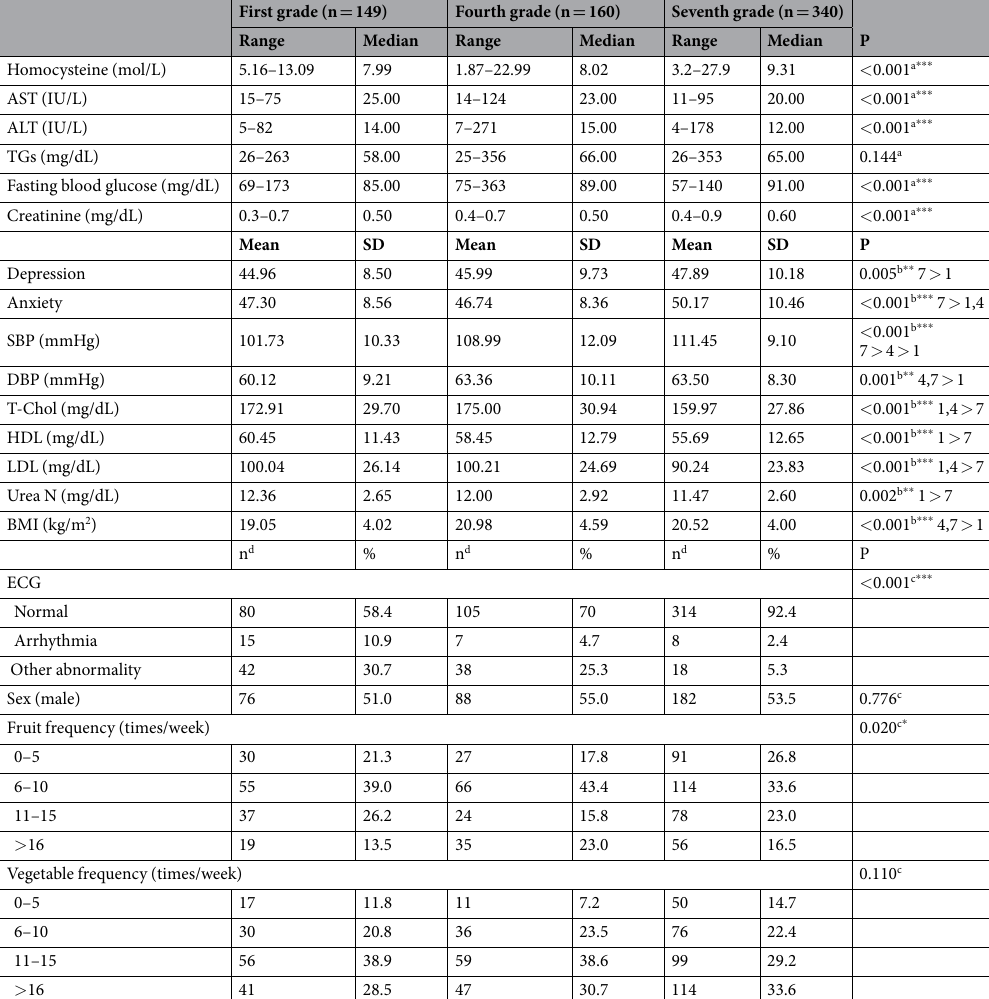
Table 2. Grade-wise distributions of characteristics and serum biochemical values. * P < 0.05; ** P < 0.01; *** P < 0.001. a Results from a Kruskal–Wallis test. b Results from a one-way analysis of variance test. c Results from a chi-square test. d Total counts may vary because of missing data. AST, aspartate transaminase; ALT, alanine aminotransferase; TGs, triglycerides; SBP, systolic blood pressure; DBP, diastolic blood pressure; T-Chol, total cholesterol; HDL, high-density lipoprotein; LDL, low-density lipoprotein; ECG,